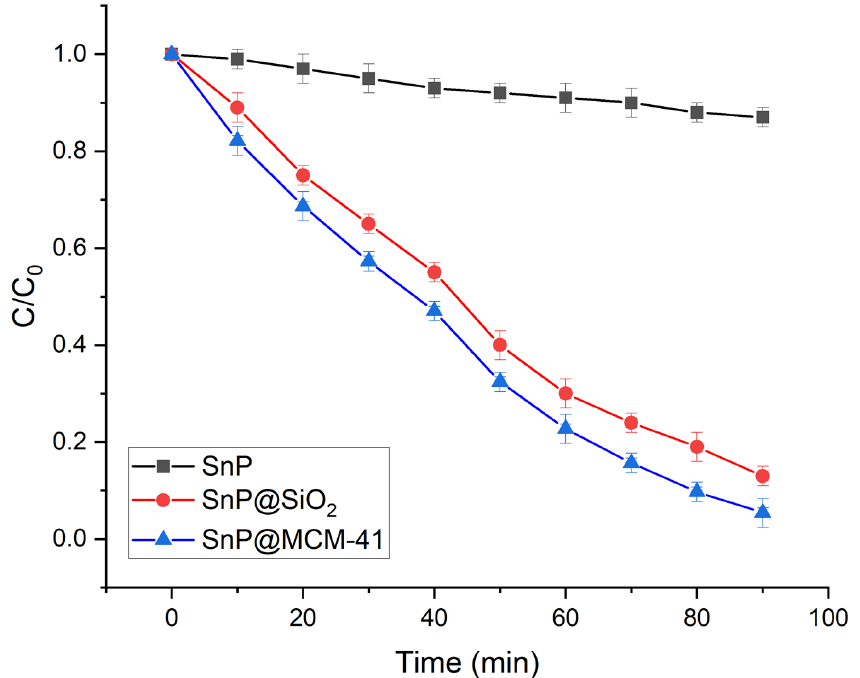
Figure 7. Photocatalytic degradation of the EG dye in an aqueous solution (pH = 7, T = 298 K) under visible light irradiation in the presence of SnP , SnP@MCM − 41 , and SnP@SiO 2 .